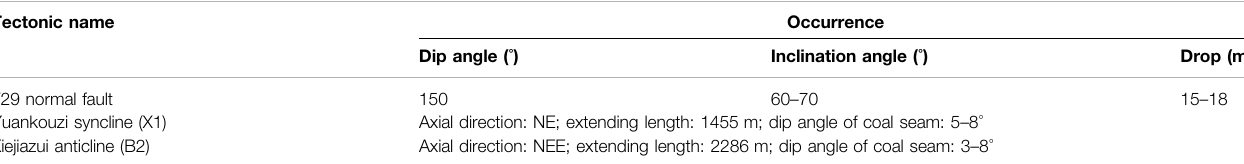
TABLE 1 | Major geological tectonic parameters of the mine fi